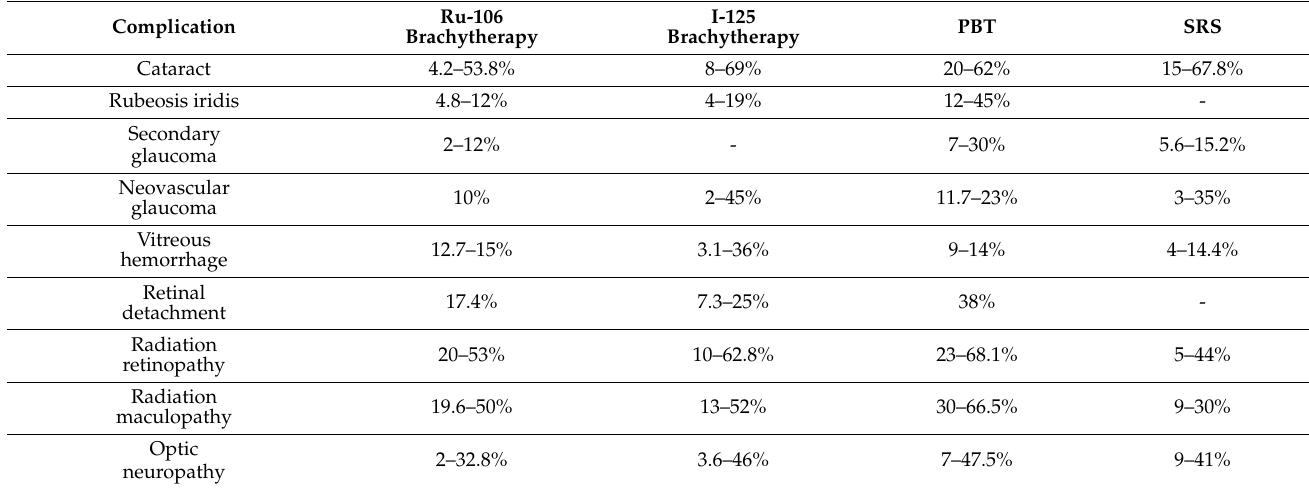
Table 1. Reported complication rates after different radiation